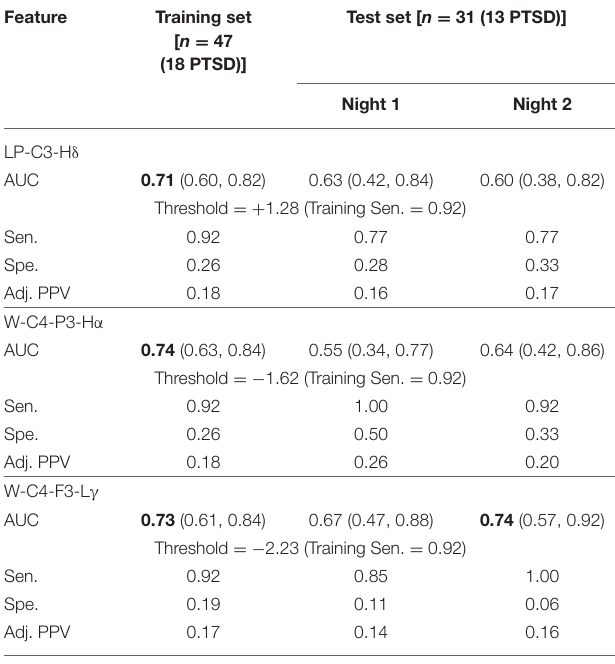
TABLE 4 | Area under the receiver operating characteristic curve (AUC) for each of the three features used in the logistic regression model.